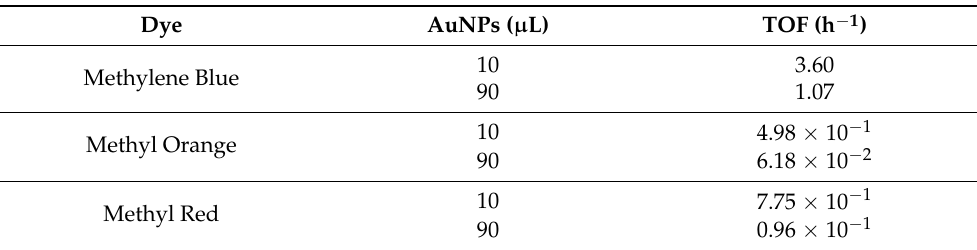
Figure 8. Scheme of the degradation mechanism proposed for ( a ) methylene blue and ( b ) methyl orange/red organic dye. Table 2. Turnover frequency (TOF) for the dyes showing the lowest and highest concentrations of